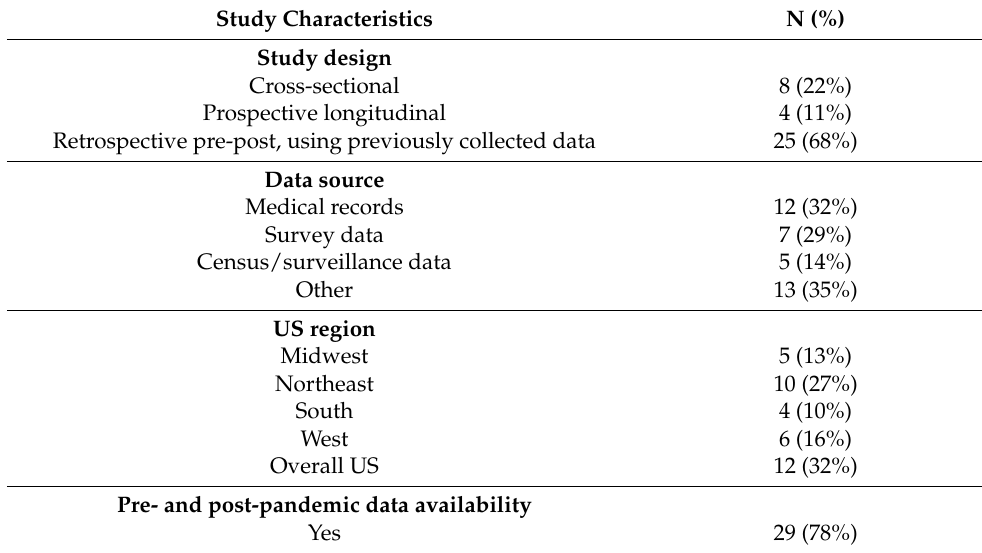
Table 1. Summary of study characteristics included in review (n = 37).